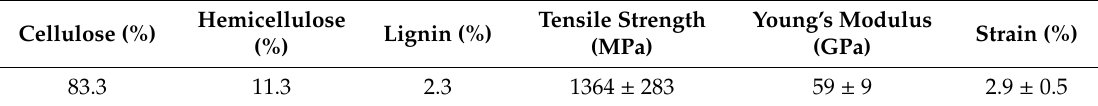
Figure 2. ( a ) Schematic representation of the multi-scale composite structure of flax elementary fiber (adapted from [40]) and ( b ) SEM image of the as-received flax fibers. Table 2. Properties of the as-received elementary flax fibers.